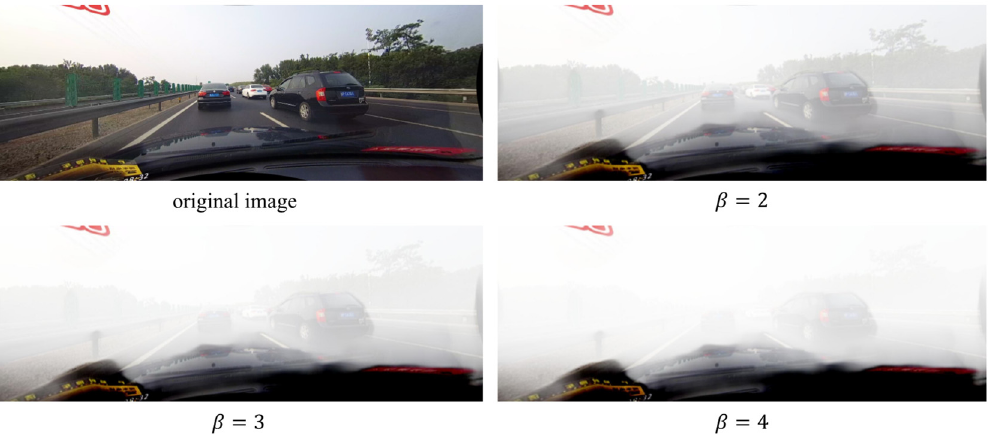
Figure 5. Example of synthetic foggy images under three different densities ( 𝛽 = 2,3,4 ), together with their clear image, with the thickness of fog increasing with 𝛽 .